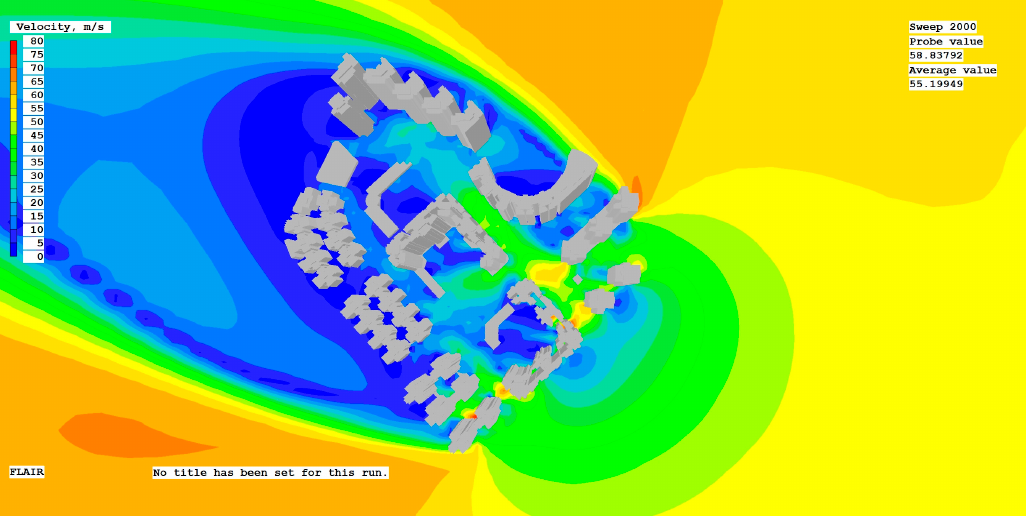
Int. J. Environ. Res. Public Health 2023 , 20 , 4143 Figure A17. Wind speed distribution under typhoon conditions (10 m height). Figure A17. Wind speed distribution under typhoon conditions (10 m height).